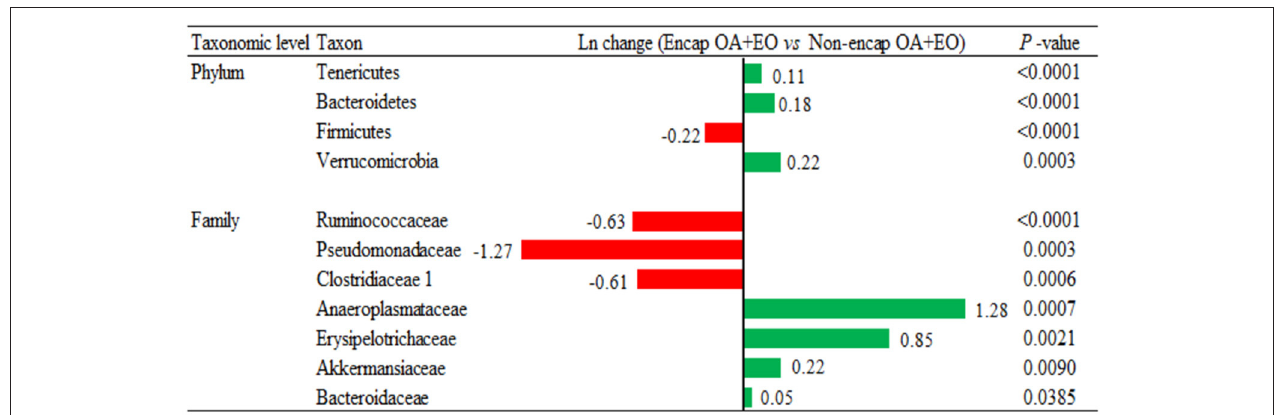
FIGURE 8 | Ln changes promoted by the supplementation of the microencapsulated mixture of fumaric acid and thymol as compared to the non-encapsulated one (fold discovery rate P -adjusted < 0.05) in taxa. Positive values ( ) and negative values ( ) indicate greater and lower abundance. Only significant taxa are presented. Differences presented are based on all taxa detected in samples per diet. NC, negative control; OA, organic acid: fumaric; EO, essential oil: thymol. Encap: microencapsulated; Non-encap, non-microencapsulated. Inclusion levels: microencapsulated fumaric acid: 1.5 g/kg; microencapsulated thymol: 3 g/kg; non-microencapsulated fumaric acid: 0.9 g/kg; non-microencapsulated thymol: 0.6 g/kg.